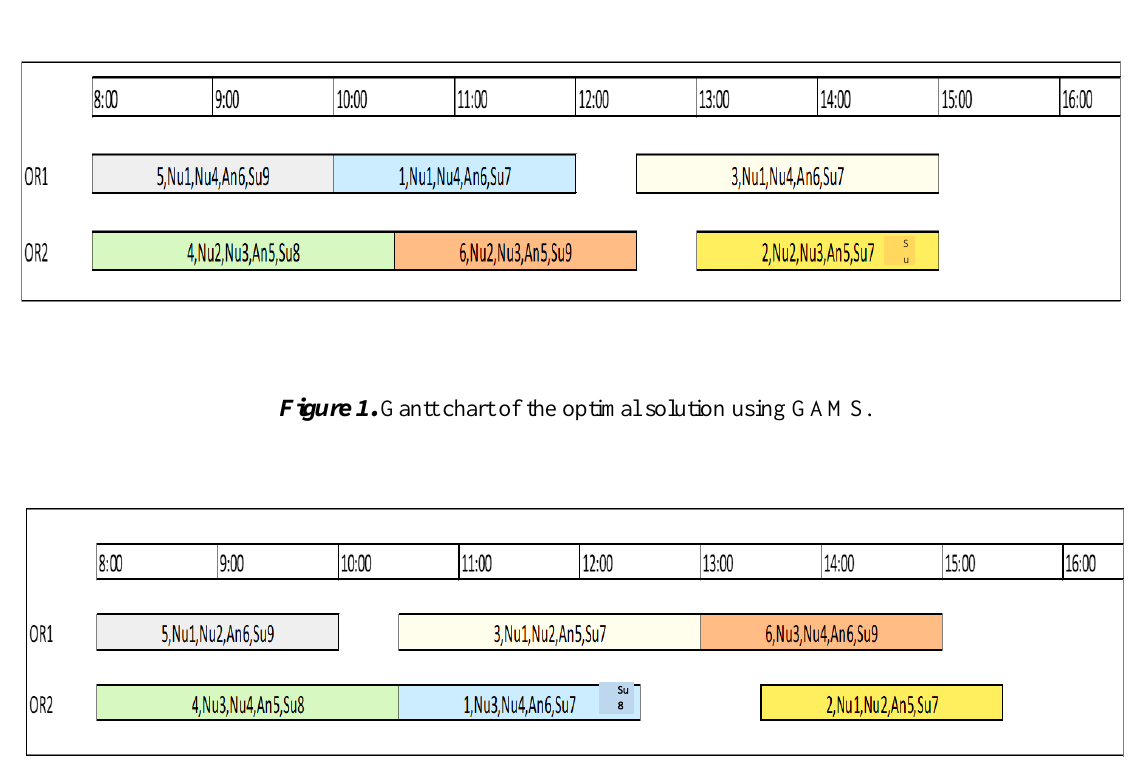
Figure 2. Gantt chart of the proposed schedule by the OR